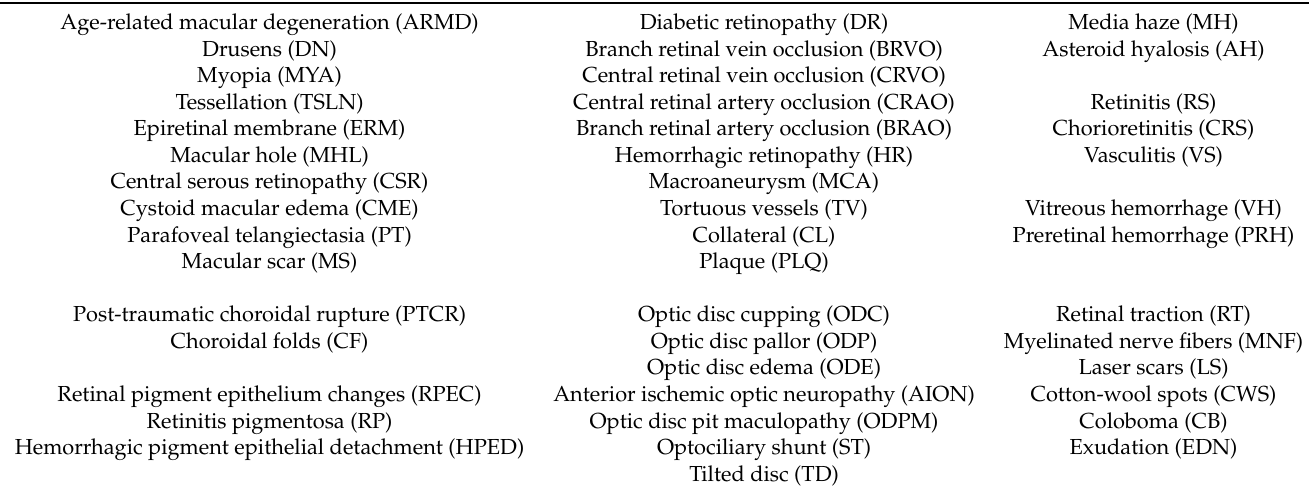
Table A2. RFMID dataset classes (conditions from similar categories grouped together, excepting those from third column and last row, grouped as